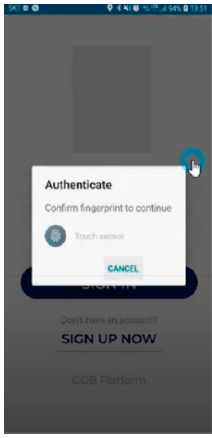
Figure 12. Main member authentication system.